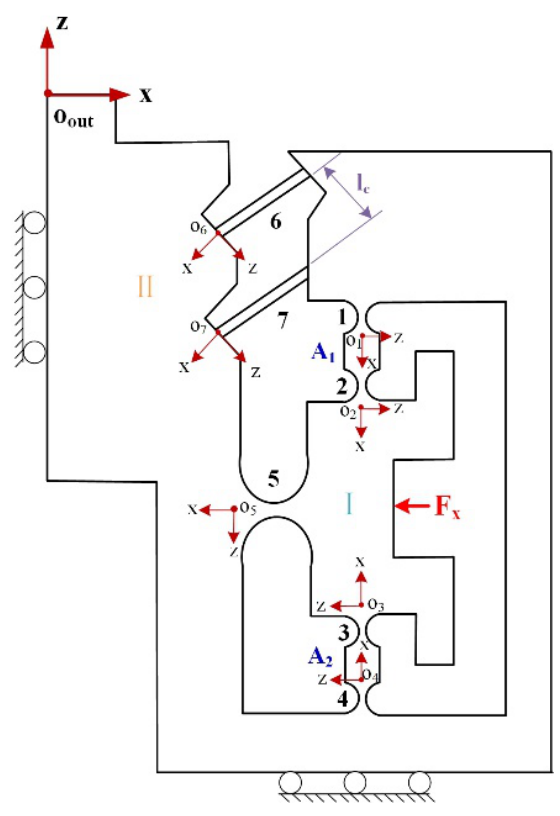
Figure 6. Schematic of module I and II.